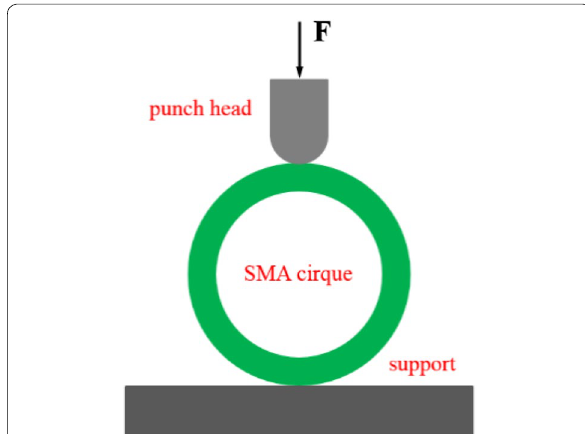
Figure 7 Shape changing process of SMA bar in a loading-unloading cycle at 317 K